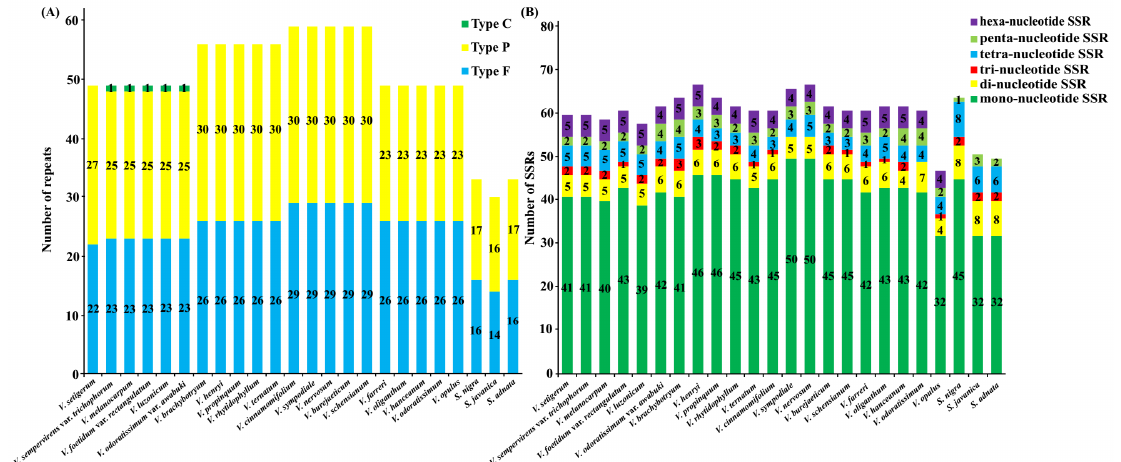
Figure 4. The distribution of repeats and SSRs in the chloroplast genomes of 24 Adoxaceae species. ( A ) Frequency of repeat types in 24 Adoxaceae species. F, P and C indicate the forward, palindrome and complement repeat types, respectively. ( B ) Compositions of the SSR in 24 Adoxaceae species. Di ff erent SSR motifs are shown in di ff erent colors.